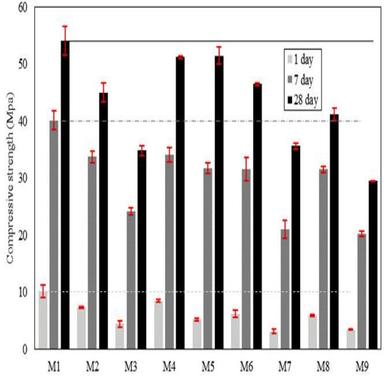
Compressive strength of mortar mixtures with different substitute materials (Results were taken as the average strength of three specimens, the error bar represents the standard deviation).